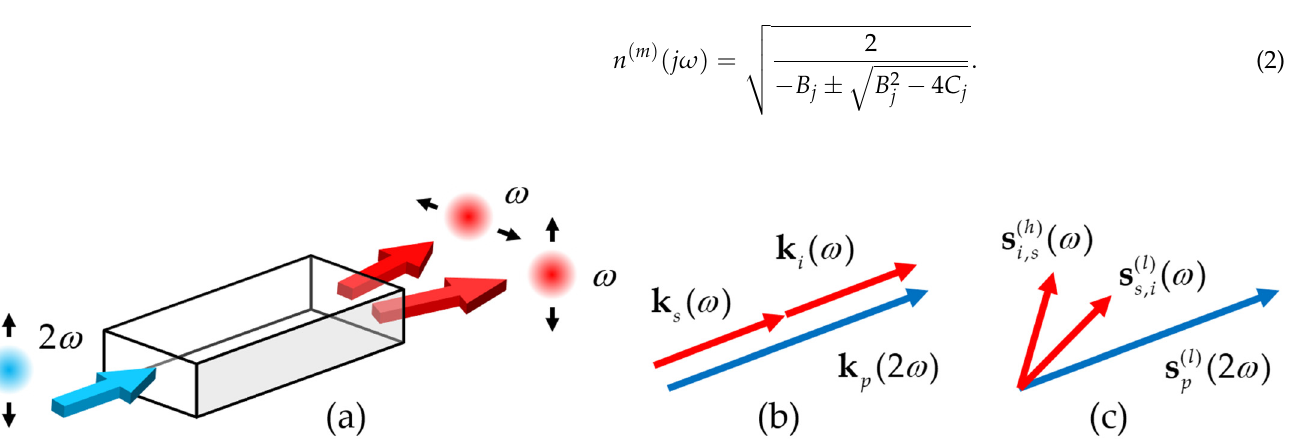
Figure 1. Schematic diagrams showing: ( a ) the relationships of frequencies and polarizations of pump, signal, and idler photons interacting via Type II spontaneous parametric down conversion (SPDC) in potassium niobate (KN), ( b ) the birefringent phase matching (BPM) between the wave vectors ( k ) of interacting waves, and ( c ) the spatial walk-off between the interacting beam lines described in the directions of Poynting vectors ( s ).